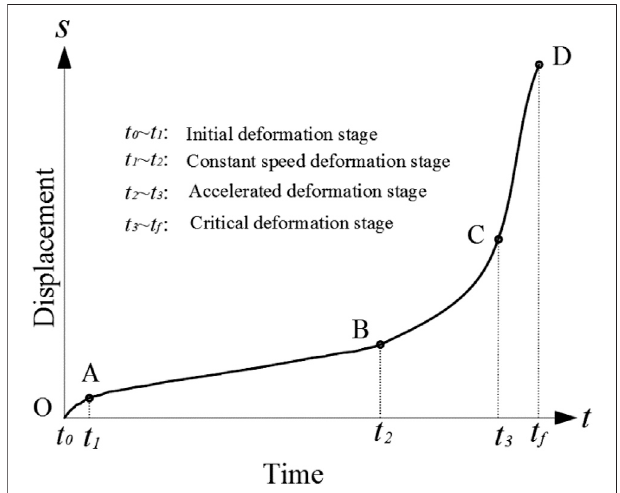
FIGURE 1 | Idealized displacement against time characterized by the initial deformation stage, the constant speed deformation stage, the accelerated deformation stage, and the critical deformation